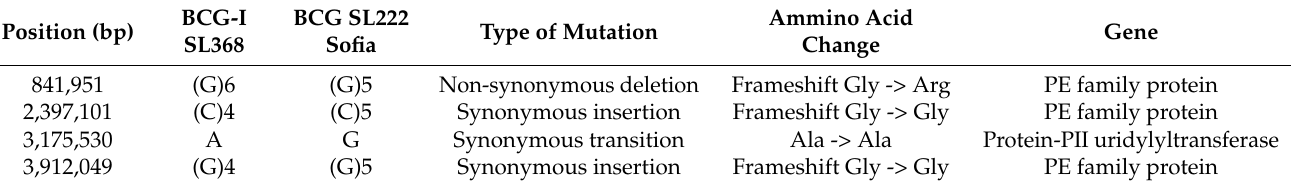
Table 2. Single nucleotide polymorphisms (SNPs) found in BCG SL222 Sofia when using BCG-I assembly NZ_CP013741 as a reference. Coordinates and frameshifted amino acids were derived by automated computational analysis by SNP calling prediction method built in Geneious Prime